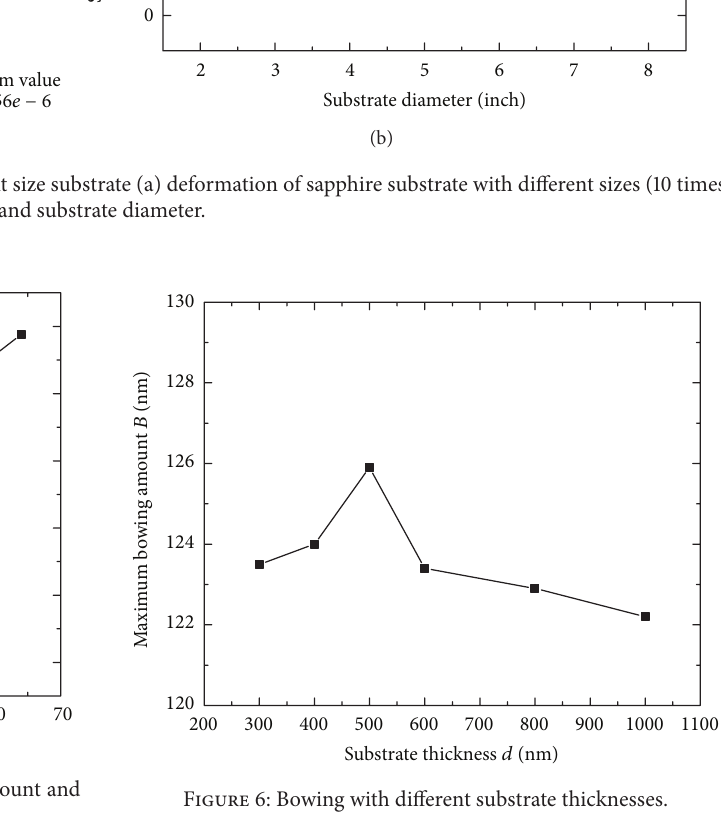
Figure 6: Bowing with different substrate